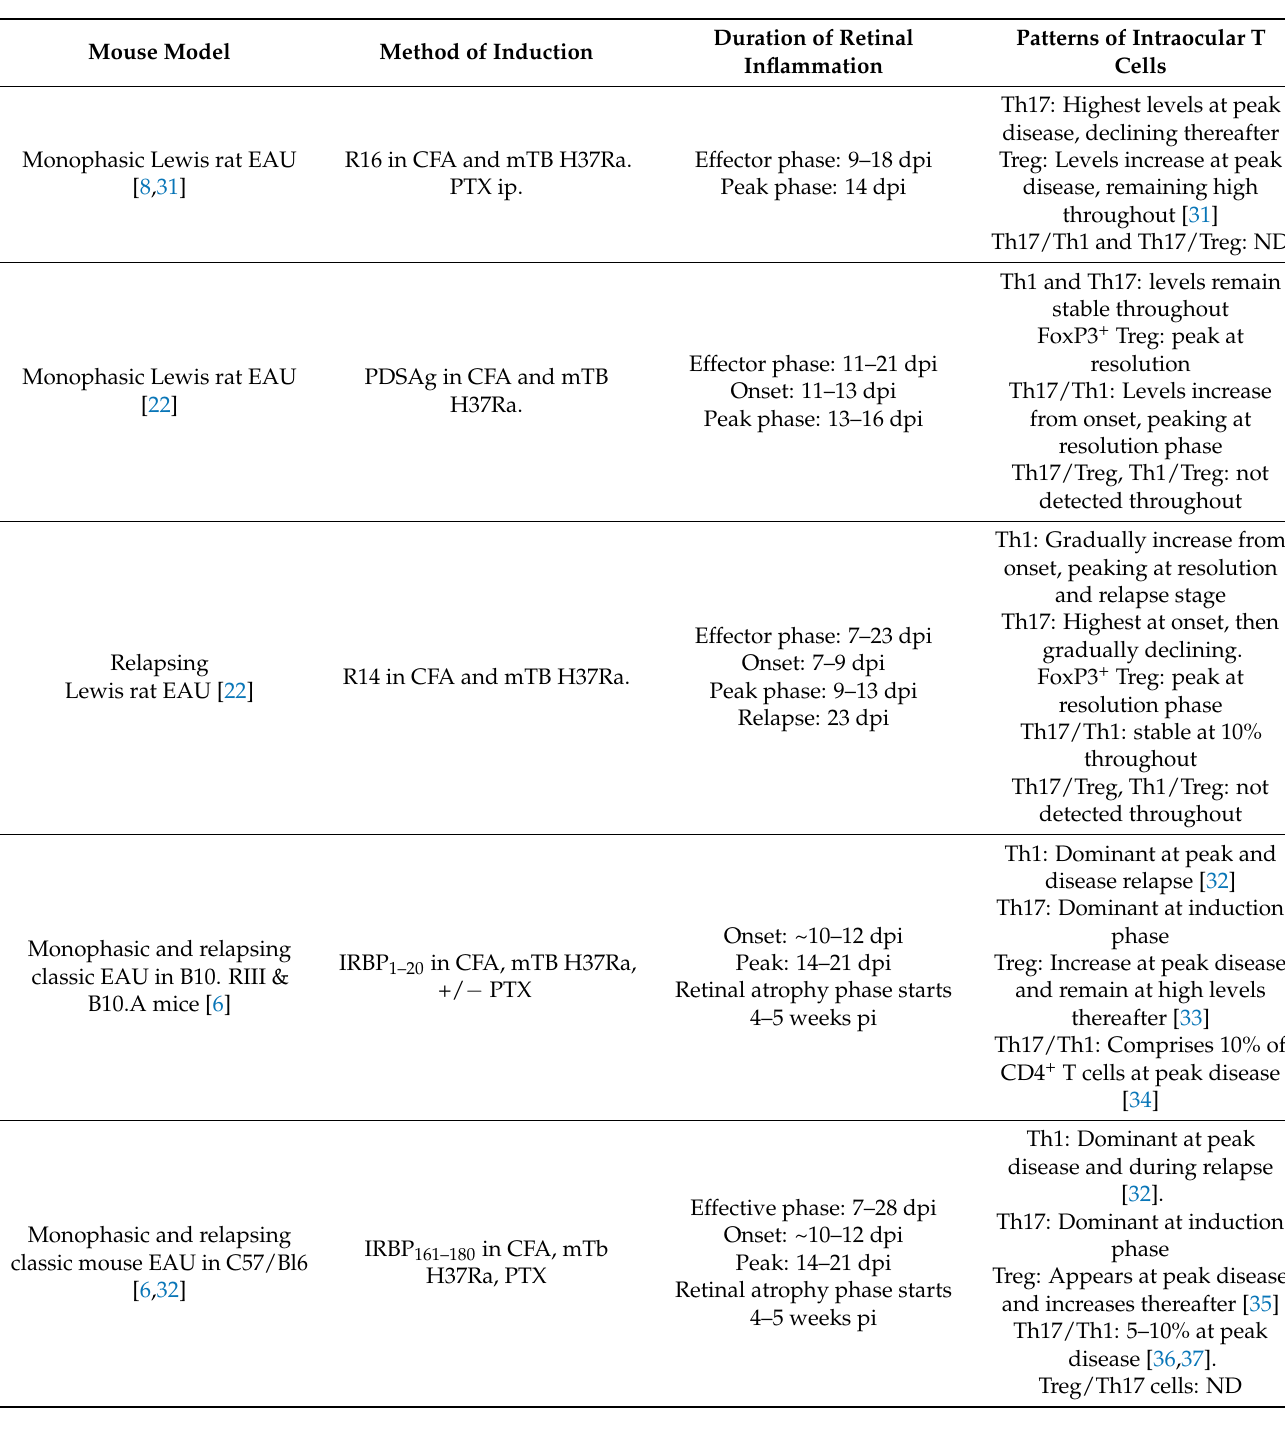
Table 1. Involvement of CD4 + T cells in induced EAU models in rat and